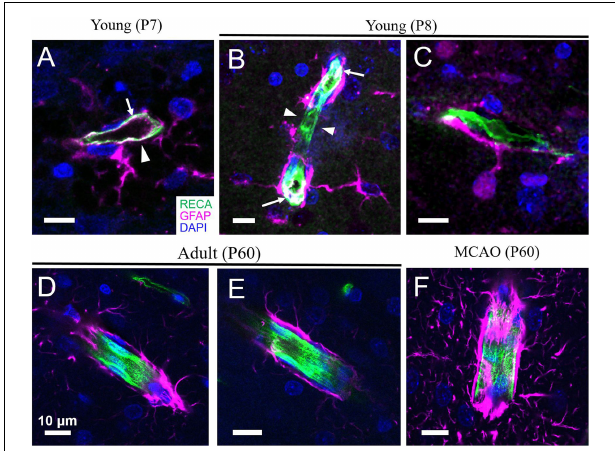
FIGURE 1 | Astrocyte coverage of arterioles during development, adulthood and after stroke. (A,B) In the cortex of developing rats, angiogenesis and astrogliogenesis is occurring concurrently. Although astrocytes begin enwrapping the vasculature immediately, this coverage is incomplete (arrowheads). GFAP expression can sometimes also be detected in the endothelium of very young rats (arrows). (C) An astrocyte with immature morphology lacking many processes is shown with a primary process extending to form an endfoot on a nearby capillary. (D,E) By mature adulthood (P60), astrocyte endfeet coverage of the blood vessels is complete. (F) Following middle cerebral artery occlusion (MCAO, a model of ischemic stroke), increased expression of GFAP and thickening of astrocyte endfeet on vessels is evident. Green = rat endothelial cell antigen-1 (RECA-1), magenta = glial fibrillary acidic protein (GFAP), blue = 4’,6-diamidino-2-phenylindole (DAPI). Scale bars = 10 µ m. [Panels D,F are reproduced, with permission, from McConnell et al.